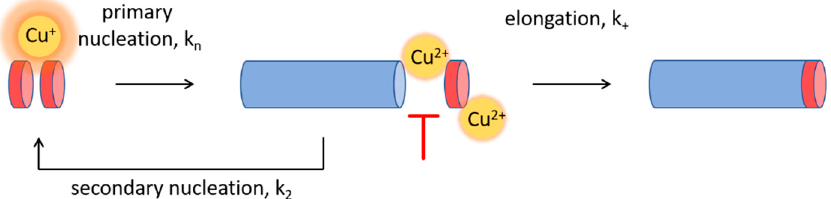
Figure 8. Schematic model showing the differential effects of Cu 2+ and Cu + on the amyloid formation of A β (1-42), with Cu 2+ acting in an inhibitory manner on elongation and Cu + mildly affecting primary nucleation.